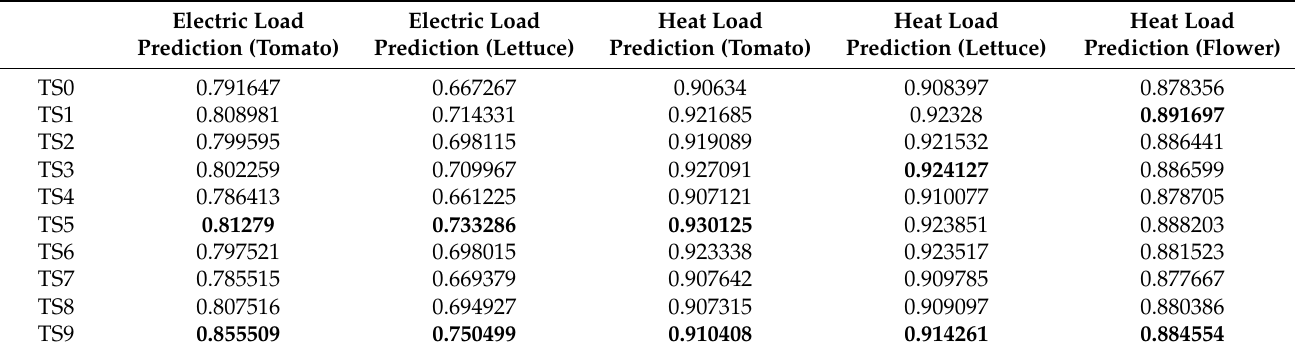
Table 10. The R 2 of each model (time series features).